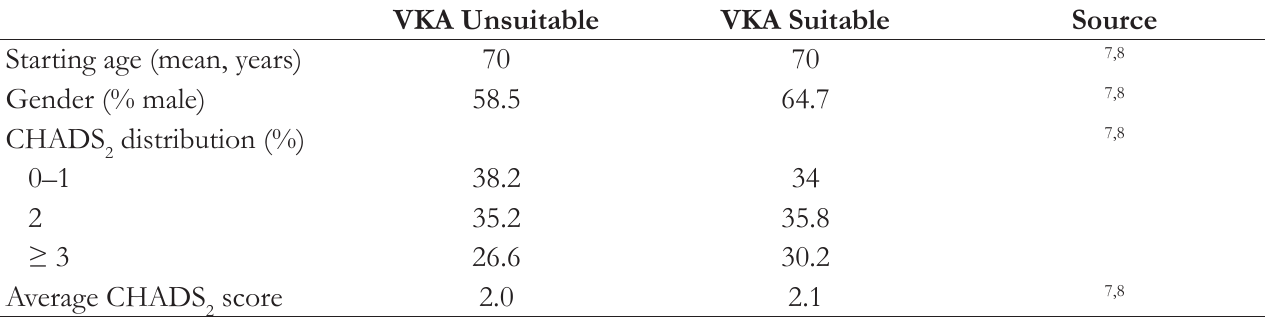
Table 1. Population Demographic and Clinical Characteristics